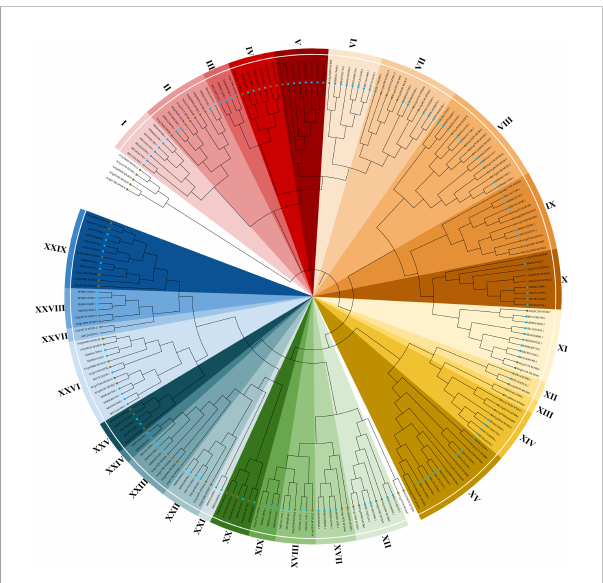
FIGURE 1 Phylogenetic analysis of R2R3-MYB transcription factors from Malus sieversii and Arabidopsis thaliana . Neighbor-joining tree of 128 M. sieversii (MsMYBs) and 94 A. thaliana (AtMYBs) R2R3-MYB TFs. The bootstrap test used 1000 replicates. The R2R3-MYB transcription factors of M. sieversii and A. thaliana are marked in blue and brown, respectively. The tree shows 29 clades (I – XXIX) with a high bootstrap value (with a different color for each clade). The uncolored region represents A. thaliana